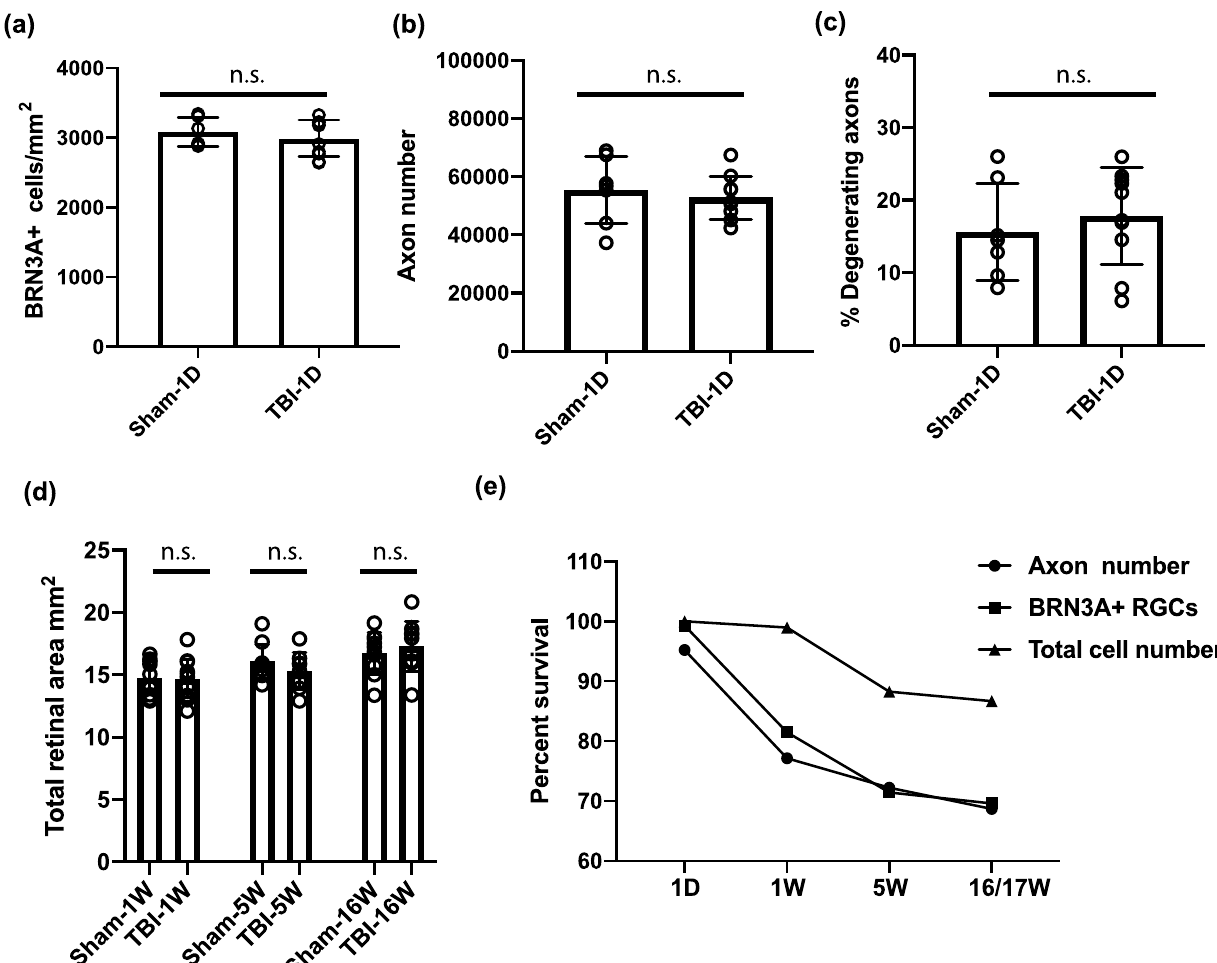
Figure 3. At 1 day after injury, no significant changes were detected in the retina or optic nerve. ( a ) Quantification of BRN3A + RGCs at 1 day (1D) post blast exposure. ( b ) Quantification of axons 1D after injury. ( c ) Percent of degenerating axons in the optic nerves 1D after injury. ( d ) Total retinal area of hematoxylin and eosin (H&E) stained whole-mount retinas at 1 week (1 W), 5 weeks (5 W), and 16 weeks (16 W) after injury. ( e ) Percent survival of BRN3A + RGCs, PPD stained axons, and total number of H&E stained cells in the ganglion cell layer. For the total cell count in the ganglion cell layer at the 1D time-point, 100% survival was assumed rather than determined experimentally. Bars represent mean ± SD and each data point represents a biological sample; unpaired two tailed t -test analysis with Welch’s correction, n.s. not significant. The graphs were generated in Prism 8 software and the figure was assembled in Adobe Illustrator CC 2014.